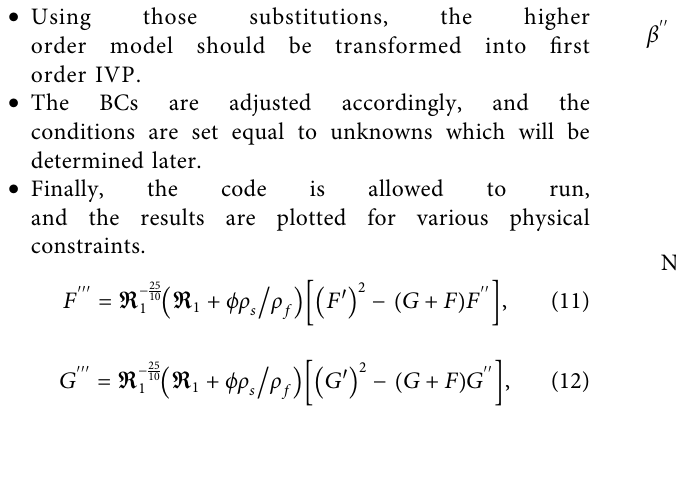
the code is allowed to run, and the results are plotted for various physical constraints.